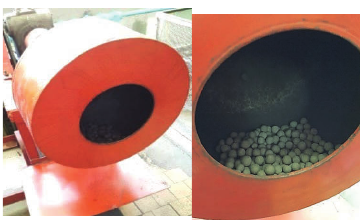
Fig. 3. Drum-type laboratory